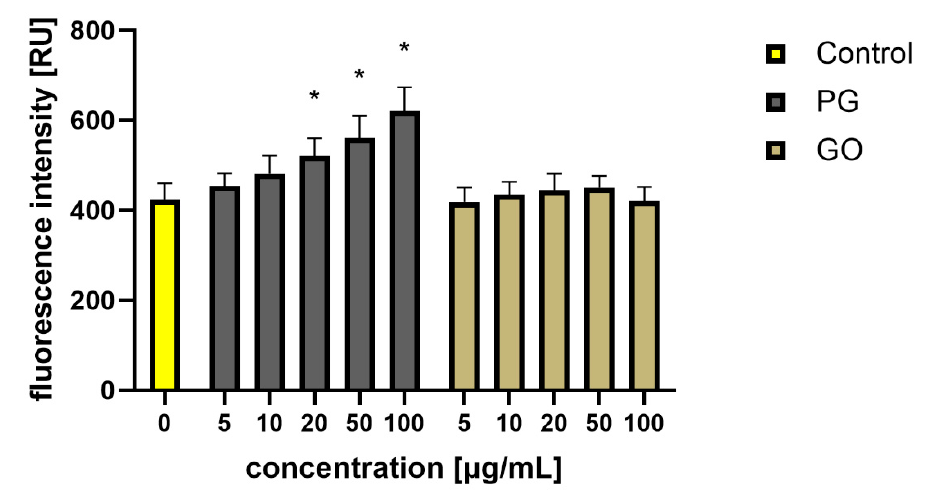
Figure 14. Analysis of the ROS production in HS-5 cells after treatment with PG and GO. Values in the rows marked with an asterisk show statistically significant differences ( p < 0.05) as compared to the control assay. Abbreviations: C—control group (untreated cells); PG—pristine graphene; GO—graphene